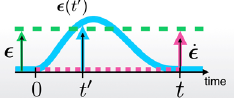
Fig. 1 Illustration of the three types of dynamical transformations considered. The system is spatially displaced by ϵ = const at all times (green dashed), analogously to the operation in equilibrium. The system is dynamically displaced by ϵ ð t 0 Þ , such that the spatial displacement vanishes at the boundaries of the considered time interval, ϵ (0) = ϵ ( t ) = 0 (cyan solid). The system is displaced instantaneously only at the latest time t , such that the differential displacement is _ ϵ dt (purple